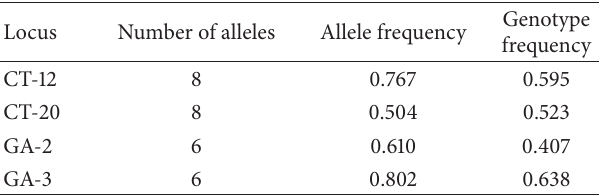
Table 1: Number of observed alleles and frequencies of most common allele and genotype for each locus.